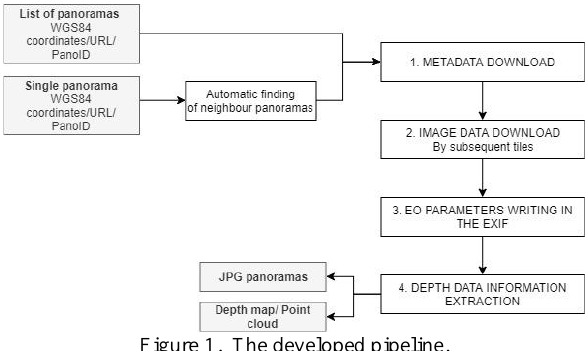
Figure 1._The developed